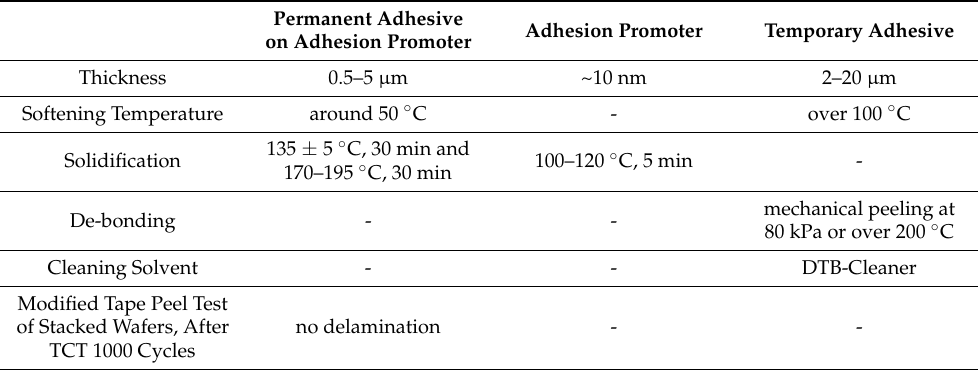
Table 1. Properties and process